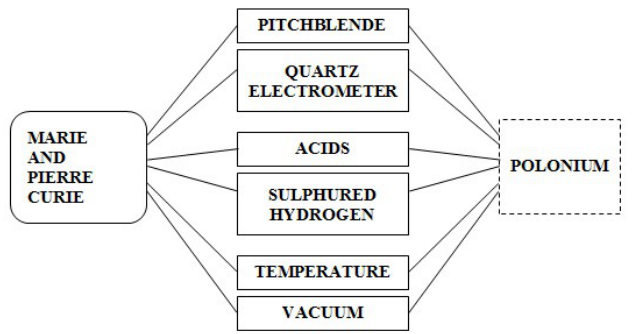
Fig. 13. Simplified graphical representation of the various actors involved in the discovery of polonium.